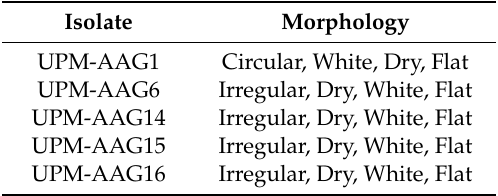
Table 1. Morphology of isolated